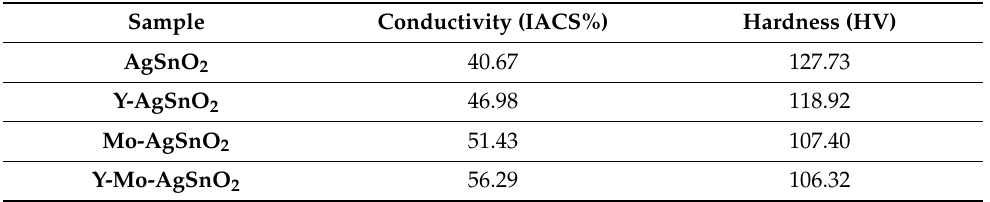
Table 7. Conductivity and